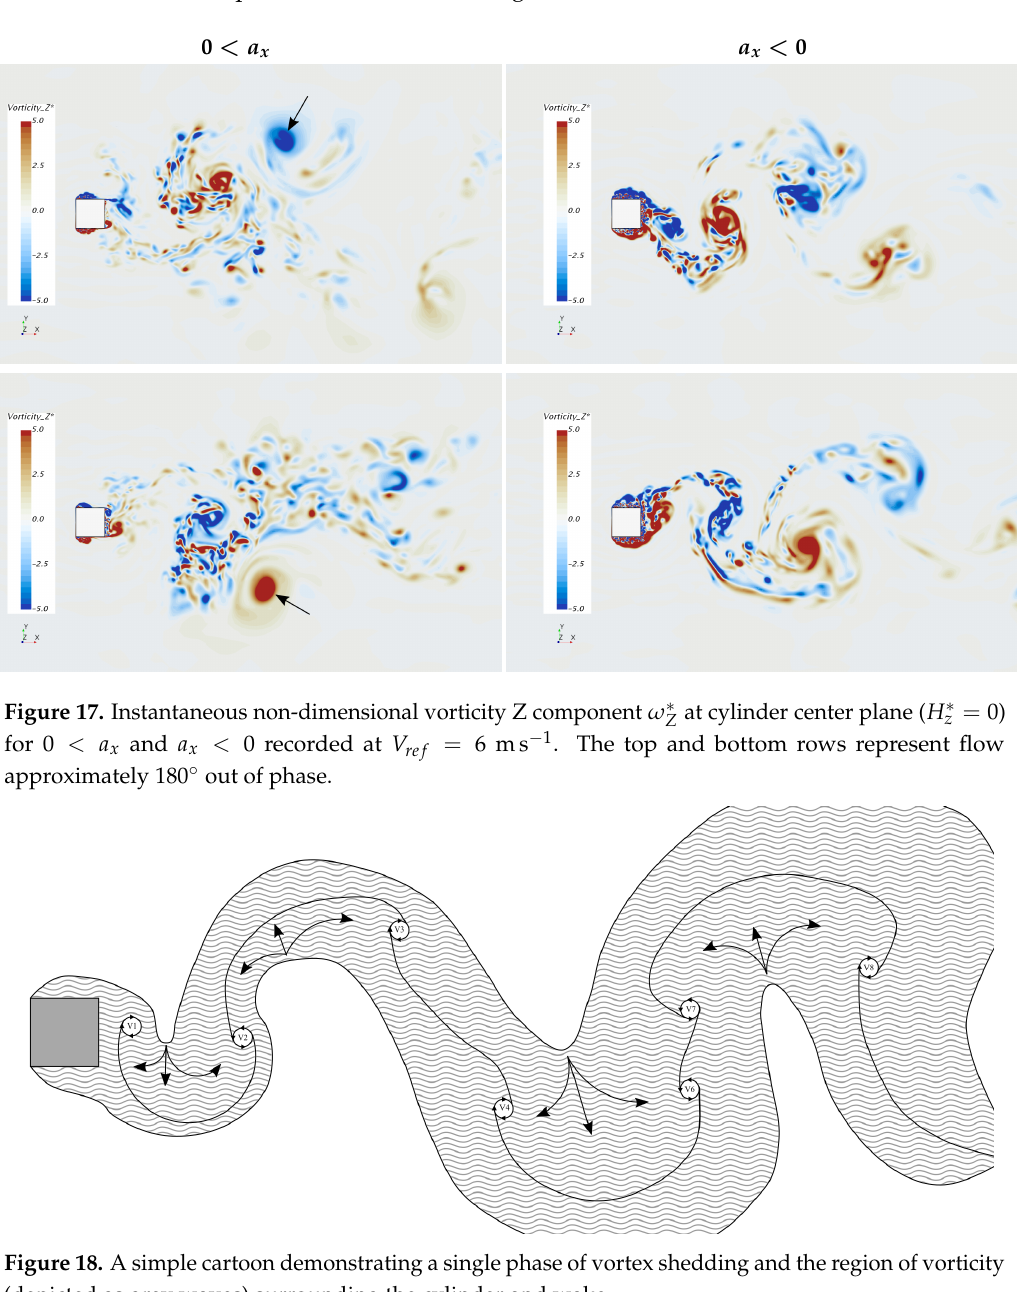
Figure 18. A simple cartoon demonstrating a single phase of vortex shedding and the region of vorticity (depicted as grey waves) surrounding the cylinder and